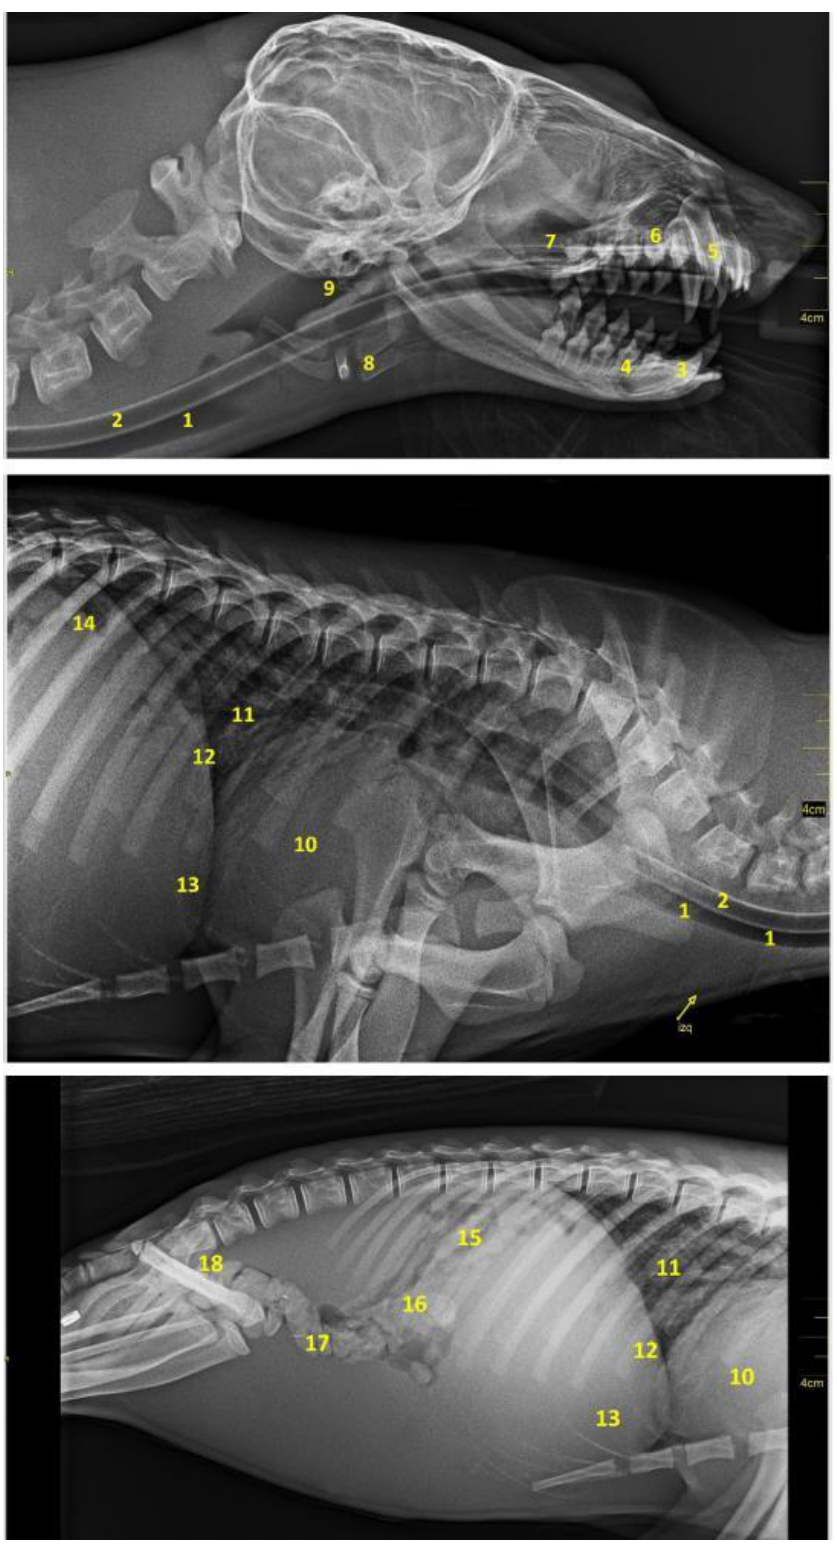
Figure 28. Radiographic images in laterolateral projection of the head, neck and cavities. (1) Trachea; (2) esophagus; (3) lower right canine; (4) lower right 2nd molar; (5) upper right canine; (6) maxillary right 2nd premolar; (7) maxillary; (8) hyoid; (9) pharynx; (10) cardiac profile; (11) bronchial tree; (12) diaphragmatic border; (13) liver; (14) stomach; (15) jejunal loops; (16) ascending colon; (17) transverse colon; (18) descending colon.